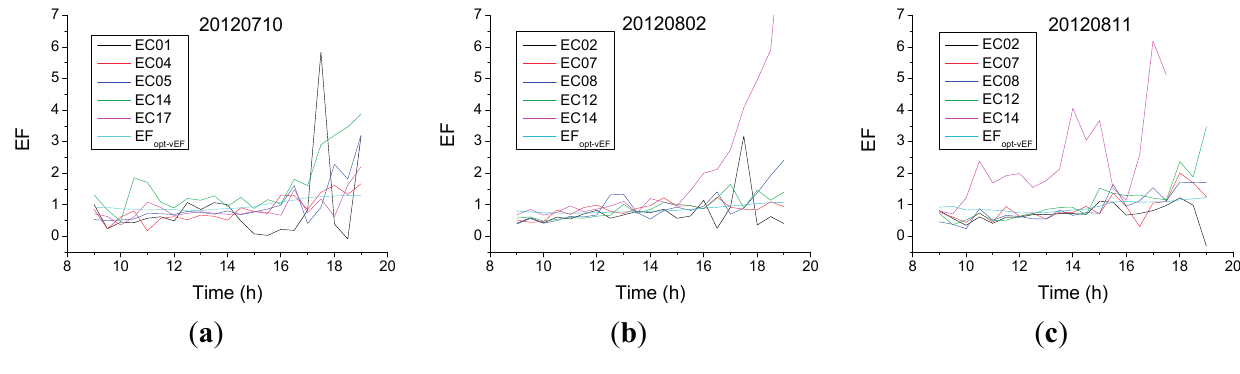
Figure 5. The EF values calculated from EC and AMS observations on ( a ) 10 July, ( b ) 2 August, and ( c ) 11 August of 2012. Note: the EF values in azure were optimized using the vEF method for EC05 on 10th July and EC08 on the other two